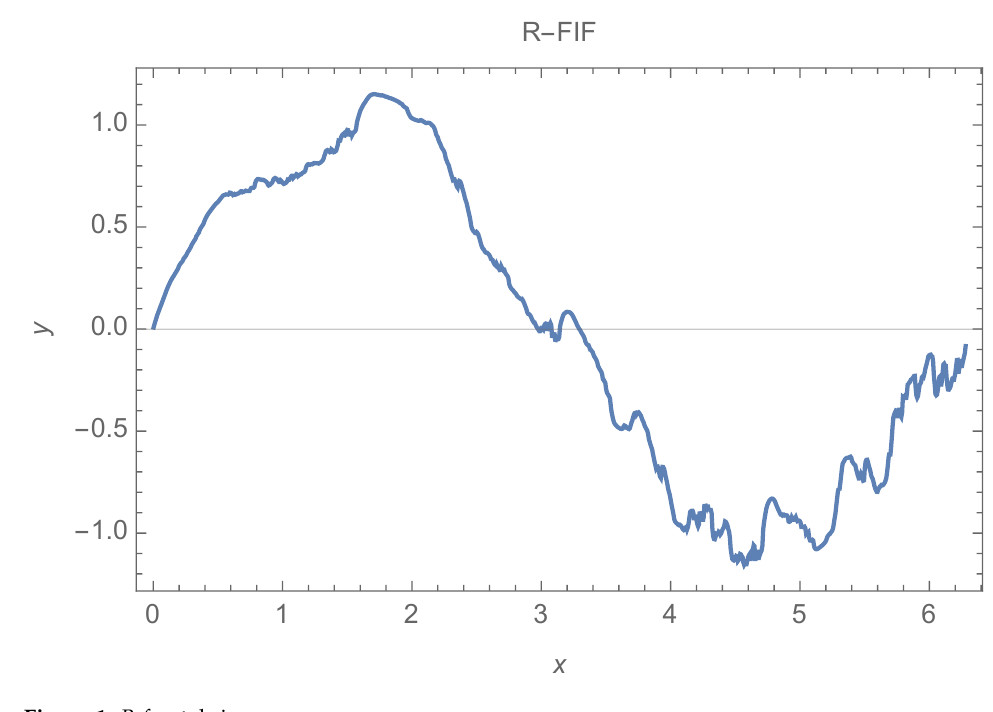
Figure 1. R -fractal